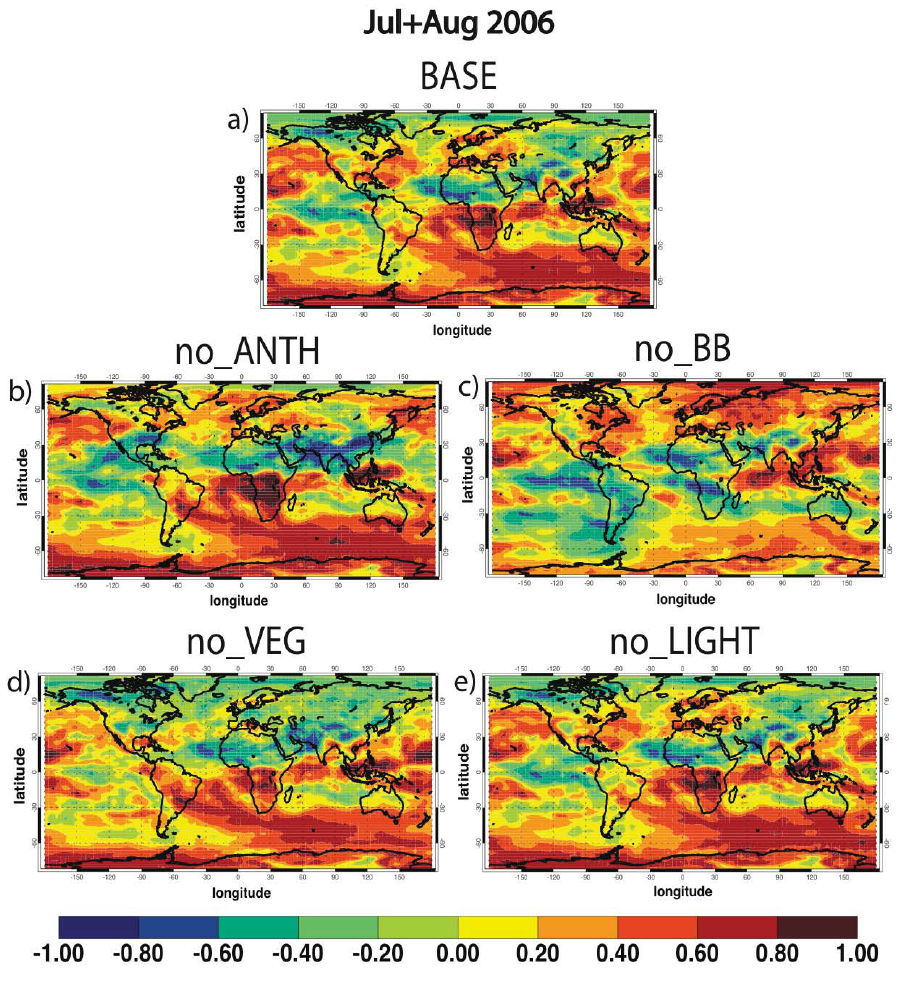
Fig. 9. Correlation coefficient of daily mean July–August 2006 middle/lower free tropospheric O 3 and CO concentrations in the BASE UKCA run (unperturbed; a ) and in 4 sensitivity runs in summer. The four runs are: (b) no anthropogenic emissions, (c) no biomass burning emissions, (d) no emissions from vegetation (isoprene and acetone), and (e) no lightning emissions. All model data that fall into the 800– 400hPa region have been used (no time sampling/averaging kernel